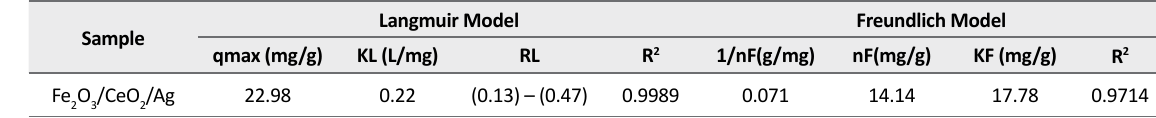
Table 2. Kinetic analysis parameters for 2,4-D photodegradation using Fe